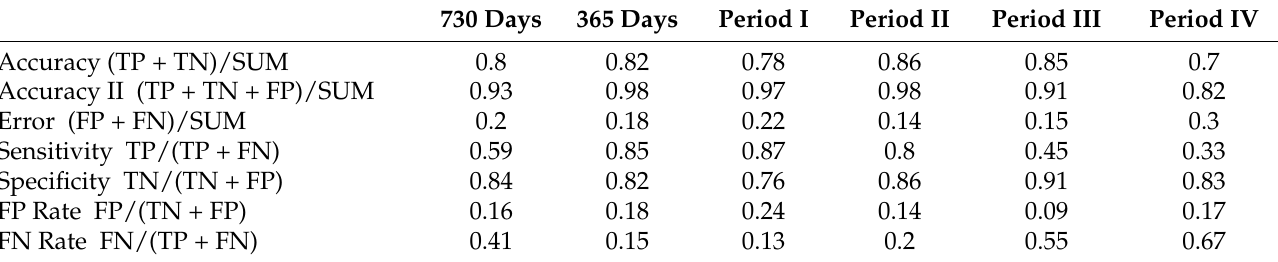
Table 3. Metrics calculated from confusion